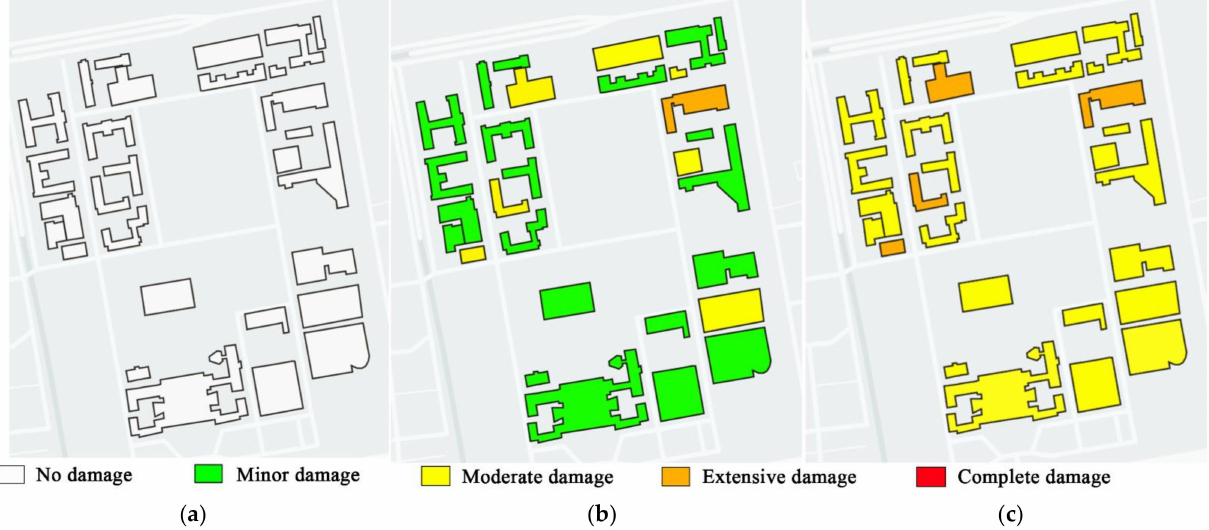
Figure 10. Structural damage states under different earthquake intensities: ( a ) frequent earthquake; ( b ) rare earthquake; ( c ) extremely rare